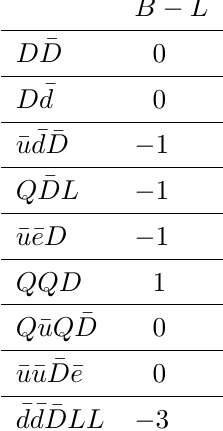
Table 2 . Some flat directions associated with D and/or ¯ D and their B − L charges. The Dirac mass term is neglected to define the flat